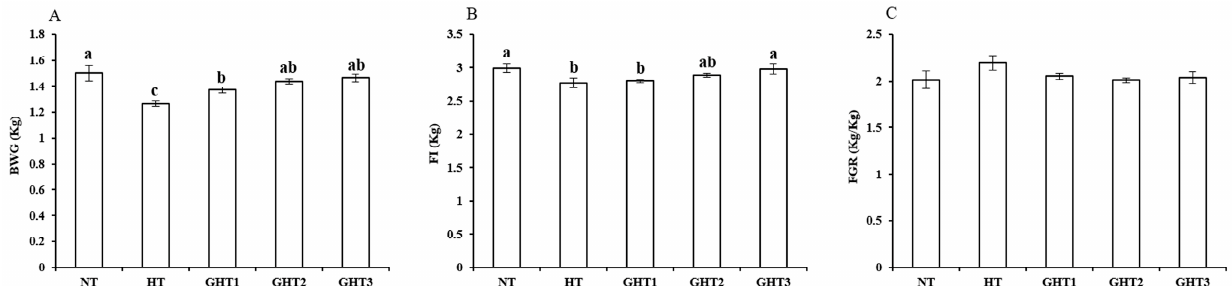
Figure 1. Effect of Gln on growth performance of broilers exposed to high temperature conditions. ( A ) BWG; ( B ) FI; ( C ) FGR. Different lowercase letters above each column indicate significant ( p < 0.05) differences among the groups. NT group: Broilers were kept in a normal temperature environment and fed a basal diet. HT, GHT1, GHT2, and GHT3 groups: Broilers in these groups were kept in high temperature conditions and fed a basal diet supplemented with 0%, 0.5%, 1.0%, and 1.5% Gln.